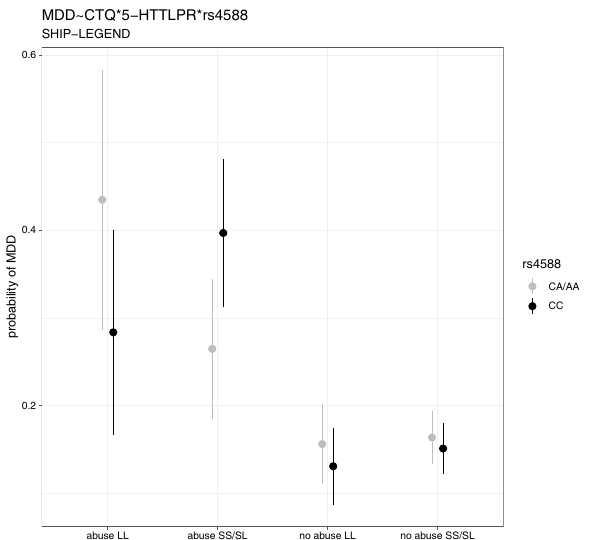
Figure 2. Mean and confidence intervals for probabilities of lifetime depression (MDD) for different subgroups of the three-way interaction childhood trauma questionnaire (CTQ, abuse vs. no abuse), 5-HTTLPR (LL vs. SL/ SS) and rs4588 (CC vs. CA/AA) in